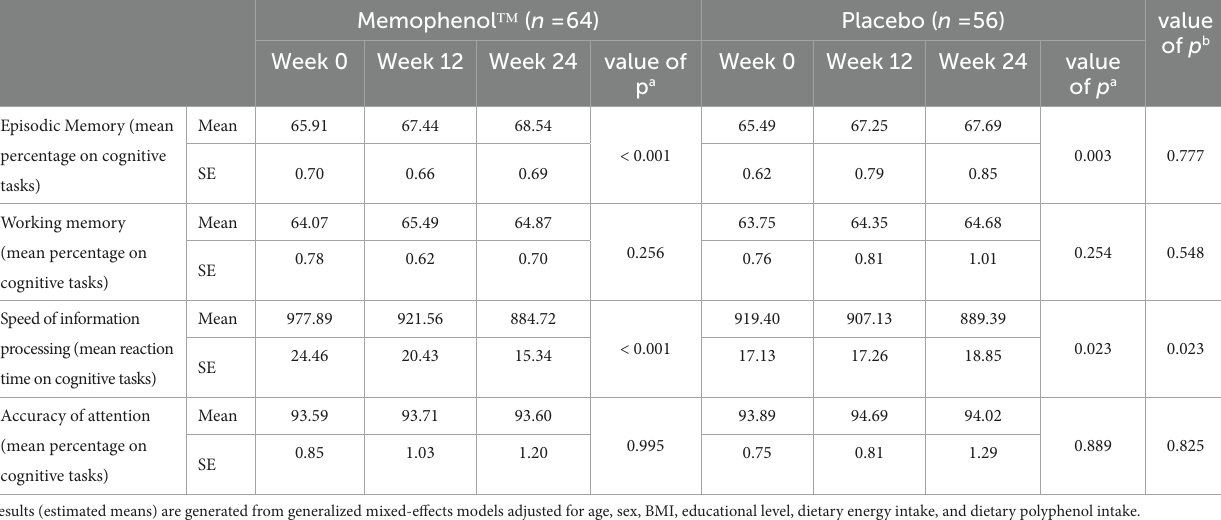
TABLE 2 Change in cognitive performance (estimated marginal